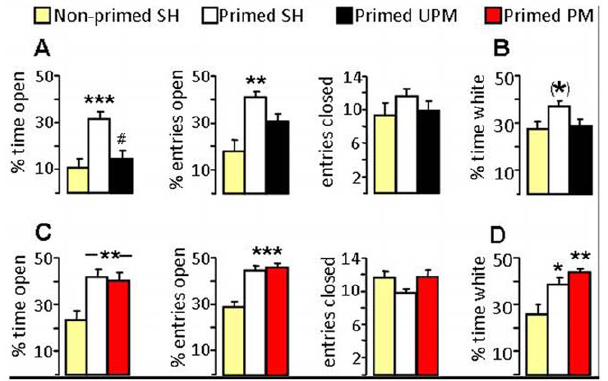
Figure 2. Effects of priming, unpaced (UPM) and paced mating (PM) on anxiety-related behavior. Female, ovariectomized Wistar rats which were either steroid-primed or non-primed were tested on the elevated plusmaze (A, C), or in the black-white box (B, D) 30 min after a 30-min period of single-housing (SH), UPM (A, B) or PM (C, D). Priming-induced anxiolysis remained after PM, but not after UPM, indicated by longer and more frequent exploration of the open and unprotected arms of the plusmaze or the white compartment of the black-white box. Locomotor activity was reflected by the number of closed arm entries on the plusmaze (A, C). Data represent mean + S.E.M. Group size between 9 and 16. *** P , 0.001, ** P , 0.01, * P , 0.05 versus non-primed SH; (*) P=0.07 versus non-primed SH. # P , 0.01 versus primed SH.